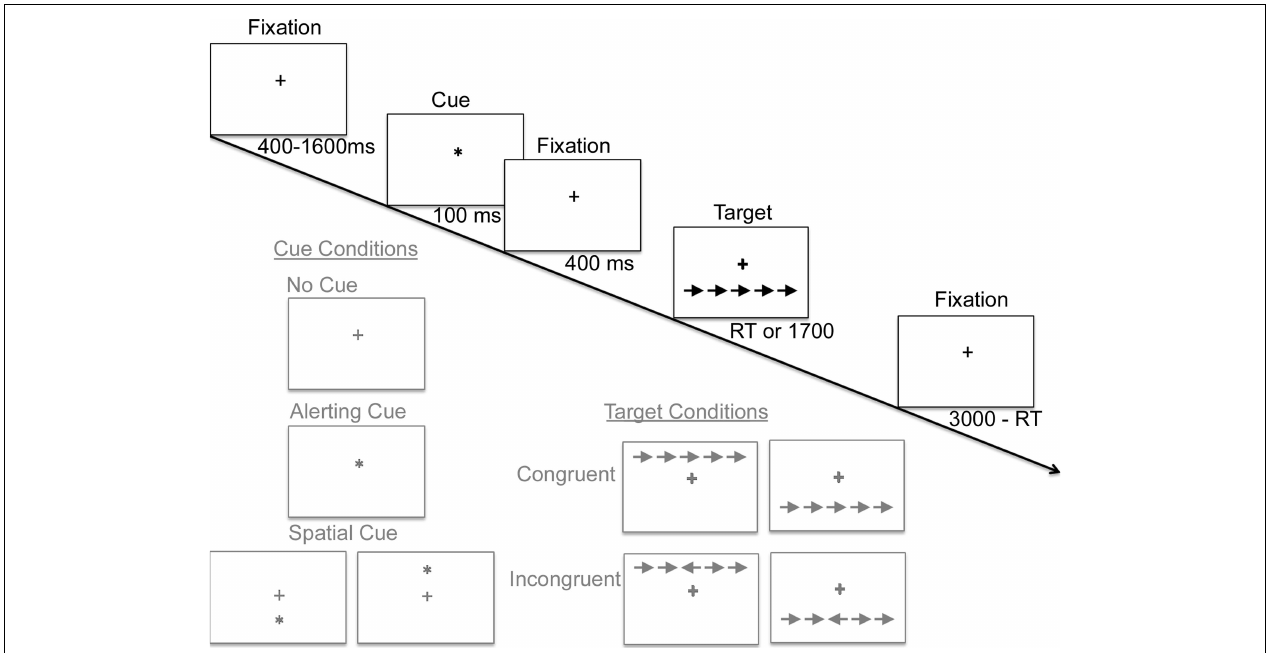
FIGURE 1 | A schematic diagram of a single trial of the Attention Network Task, in which subjects rapidly decide whether the central arrow of an array points leftward or rightward. A fi xation cross at the center of the screen remains throughout the trial. After an unpredictable duration, one of three classes of cue conditions is presented (illustrated in gray). Next, following an additional 400 ms delay, a target display appears